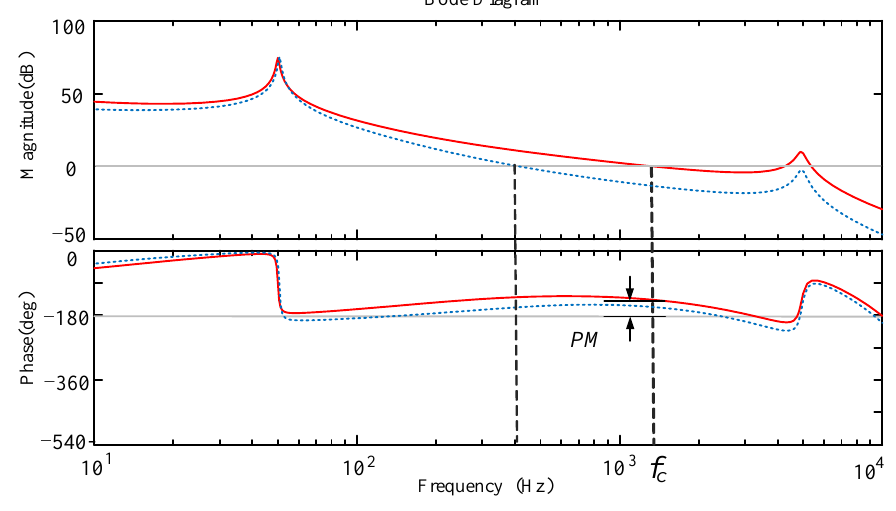
Figure 7. Bode diagram of the loop gain.